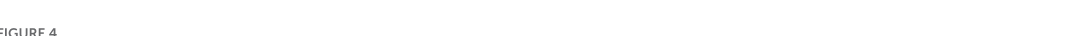
FIGURE4 neurons blocks oxycodone-induced CPP. Experiments were performed in the presence of CNO (2 mg/kg, i.p.) [ F ( 3 , 28 ) = 7.27, p = 0.0009, one-way ANOVA with Bonferroni post hoc test] (DIO-mCherry-sacch: n = 7; DIO-mCherry-Oxy: n = 8; DIO-hM4di-sacch: n = 8; DIO-hM4di-Oxy: n = 9). (J) Summary graph showing the mLs of water consumed in the unpaired and paired chambers by control and oxycodone-conditioned mice injected with DIO-mCherry or DIO-hM4di in the ACC. Experiments were performed in the presence of CNO (2 mg/kg, i.p.) [ F ( 3 , 58 ) = 3.264, p = 0.0277, two-way ANOVA with Bonferroni post hoc test] (DIO-mCherry-sacch: n = 7; DIO-mCherry-Oxy: n = 8; DIO-hM4di-sacch: n = 8; DIO-hM4di-Oxy: n = 9). ∗ p < 0.05, ∗∗ p < 0.001, ∗∗∗ p < 0.0001. RMP, resting membrane